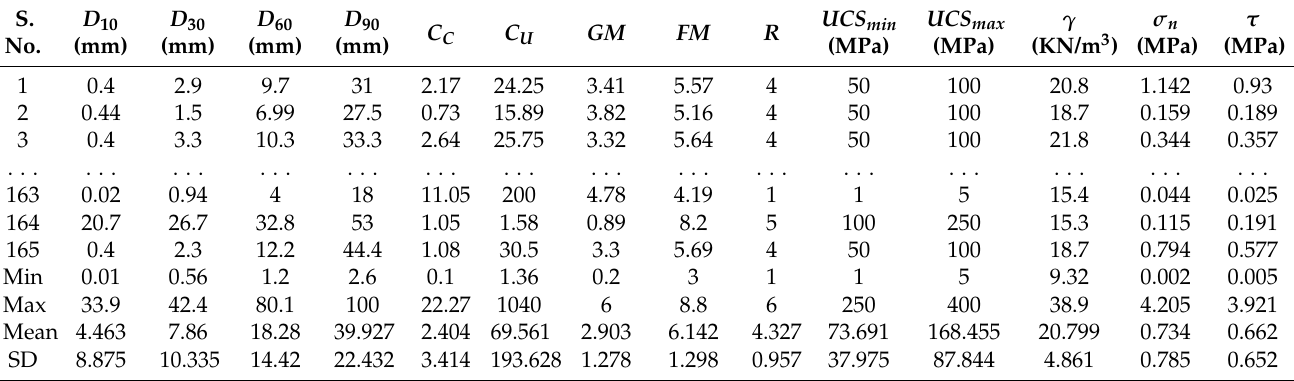
Table 1. The inputs and output of the present study.